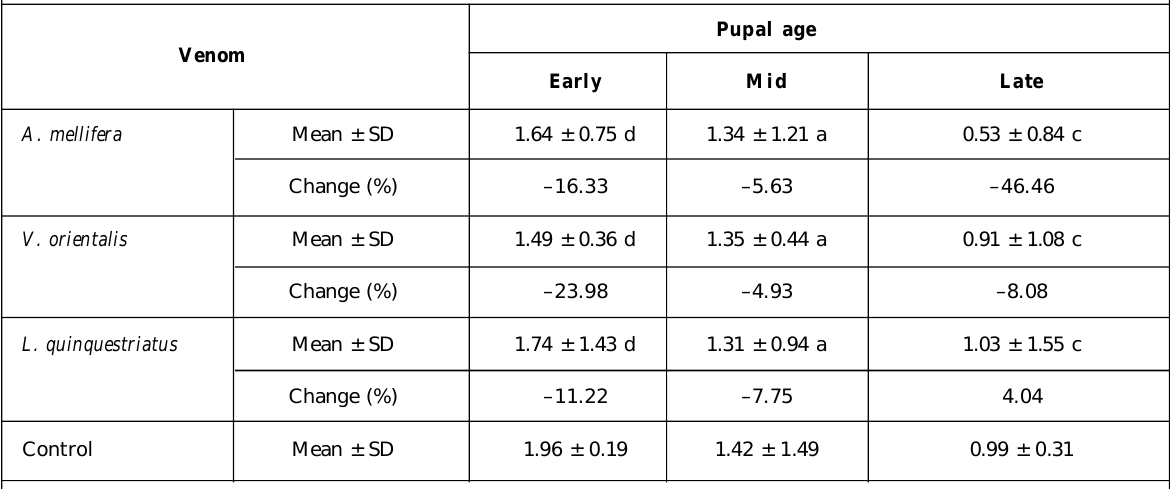
Table 3: Influenced total lipid content (mg/g) in the larval tissues after treatment of the 3 rd instar larvae of values of certain arthropod venoms G. mellonella with LC 50